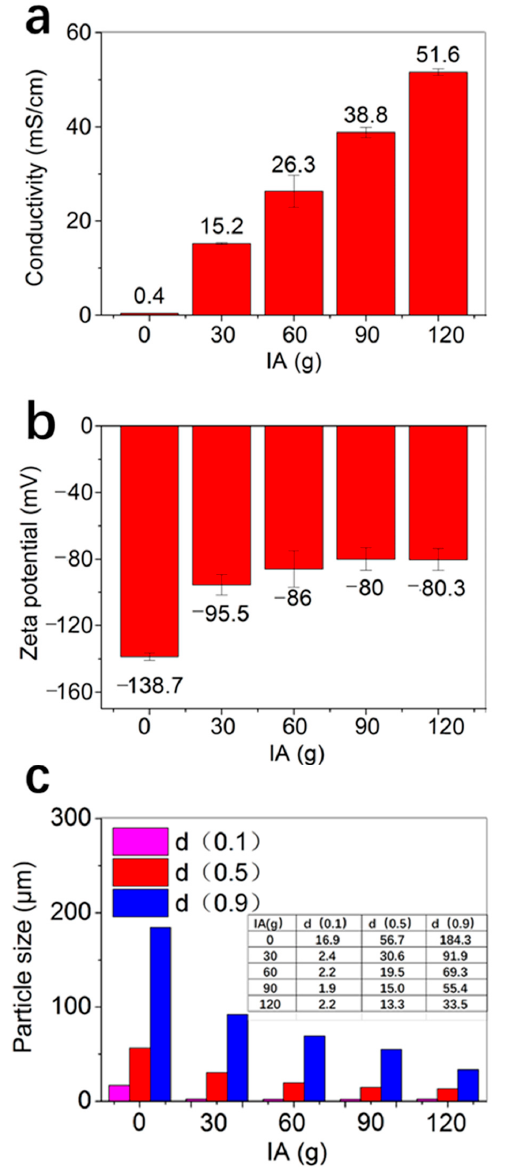
Figure 4. Conductivities ( a ), Zeta potentials ( b ), and particle sizes ( c ) of the fire-resistant paper pulps based on ultralong HAP nanowires with different added amounts of IA.